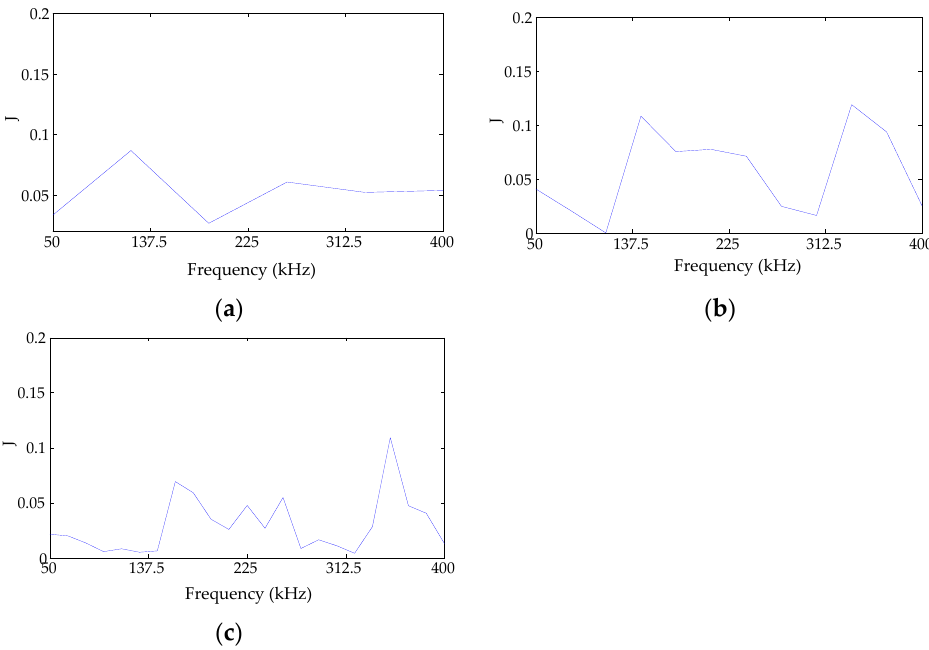
Figure 11. Feature scattering index J for adopting spindle AE signals: ( a ) bandwidth size 64 KHz; ( b ) bandwidth size 32 KHz; ( c ) bandwidth size 16 KHz.